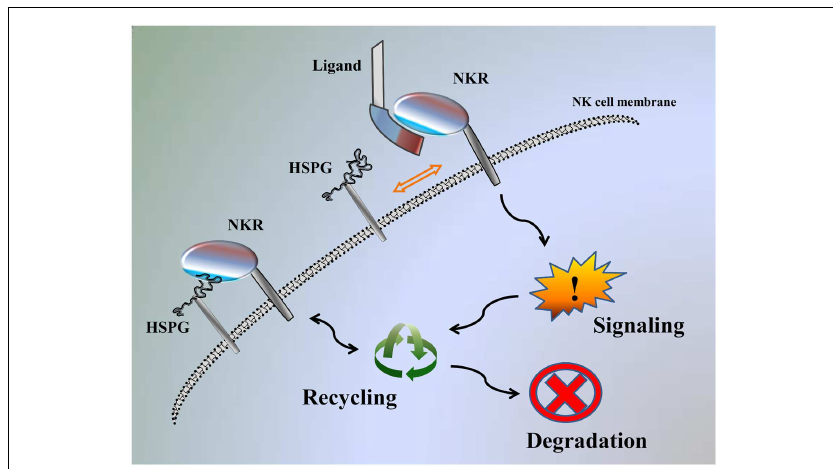
FIGURE 1 | Model of NK-function autoregulation by HSPG . Interaction of NKR with the HSPG on the NK cell surface: NKR can be recycled back to the cell surface, promote signaling or destined for degradation. If cells are exposed to ligand stimulation, this displaces HSPG from interacting and NKR is instead available to promote signaling and then can be recycled, or destined for degradation.